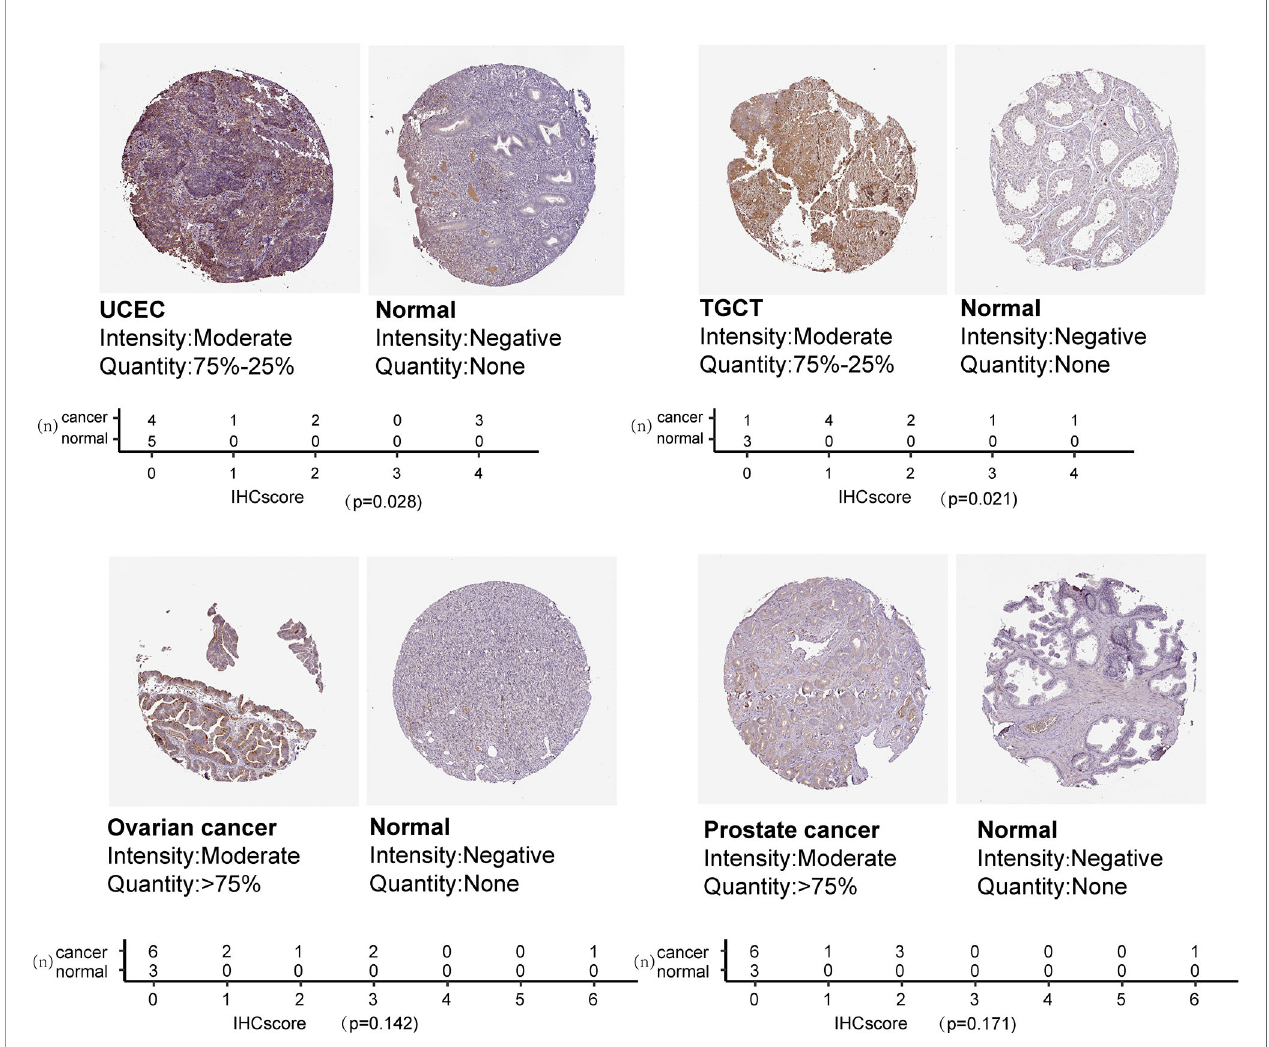
FIGURE 2 | CXCL13 protein expression based on immunohistochemistry staining and the quanti fi cation of immunohistochemical